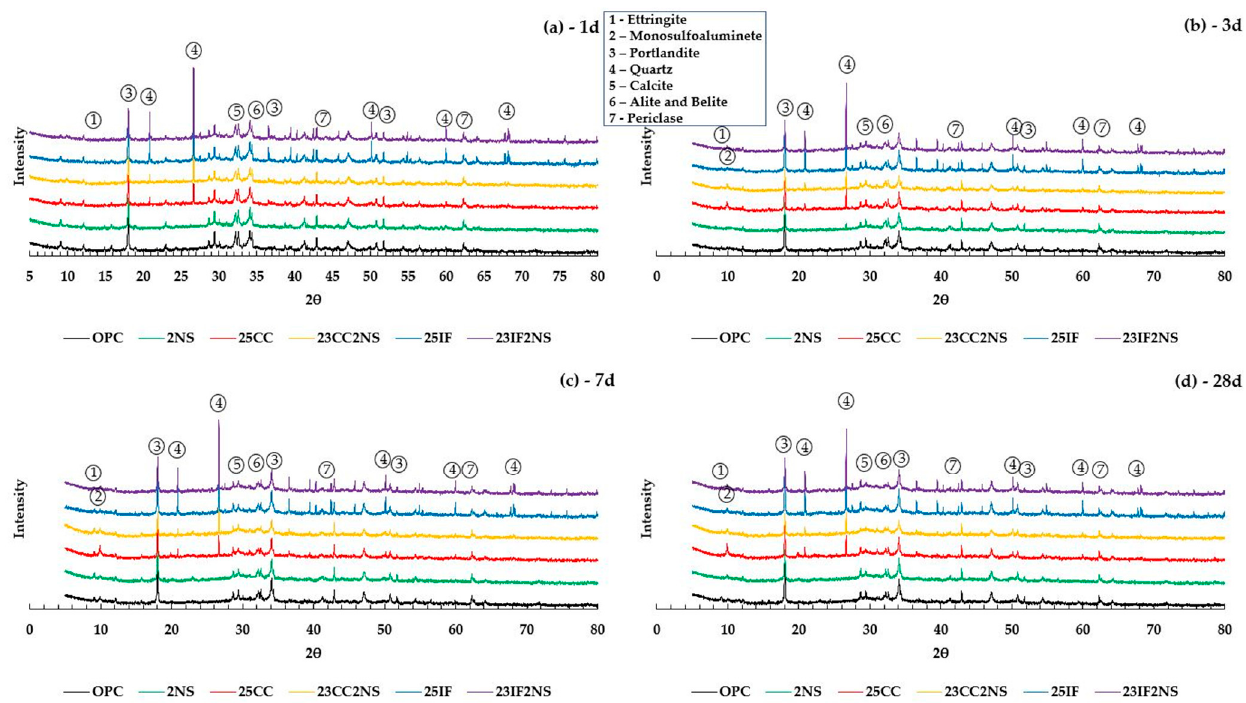
Figure 4. XRD patterns obtained for all pastes at ( a ) 1 day, ( b ) 3 days, ( c ) 7 days, and ( d ) 28 days of hydration.